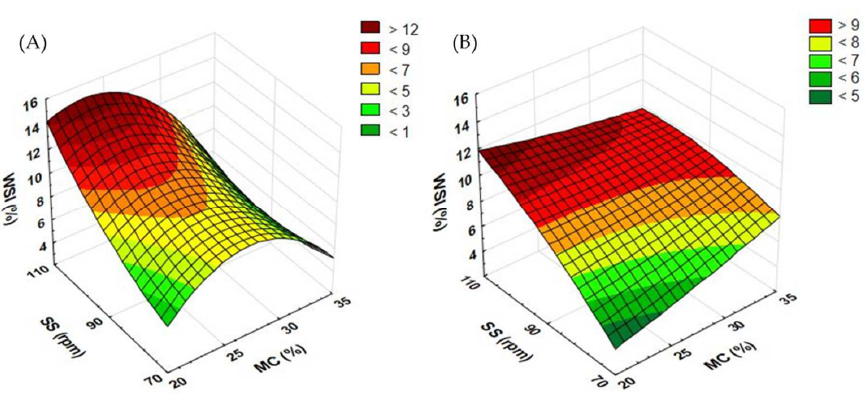
Figure 11. Results of the WSI of extrudates obtained from rapeseed straw ( A ) and buckwheat straw ( B ) after modification of the plasticizing system: MC—moisture content; SS—screw speed; WSI—water solubility index.